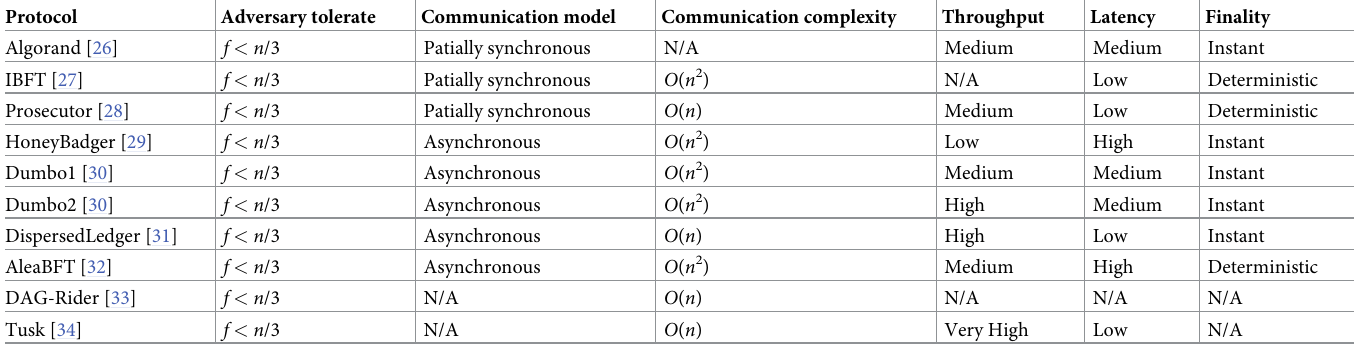
Table 1. Comparison of BFT-based consensus